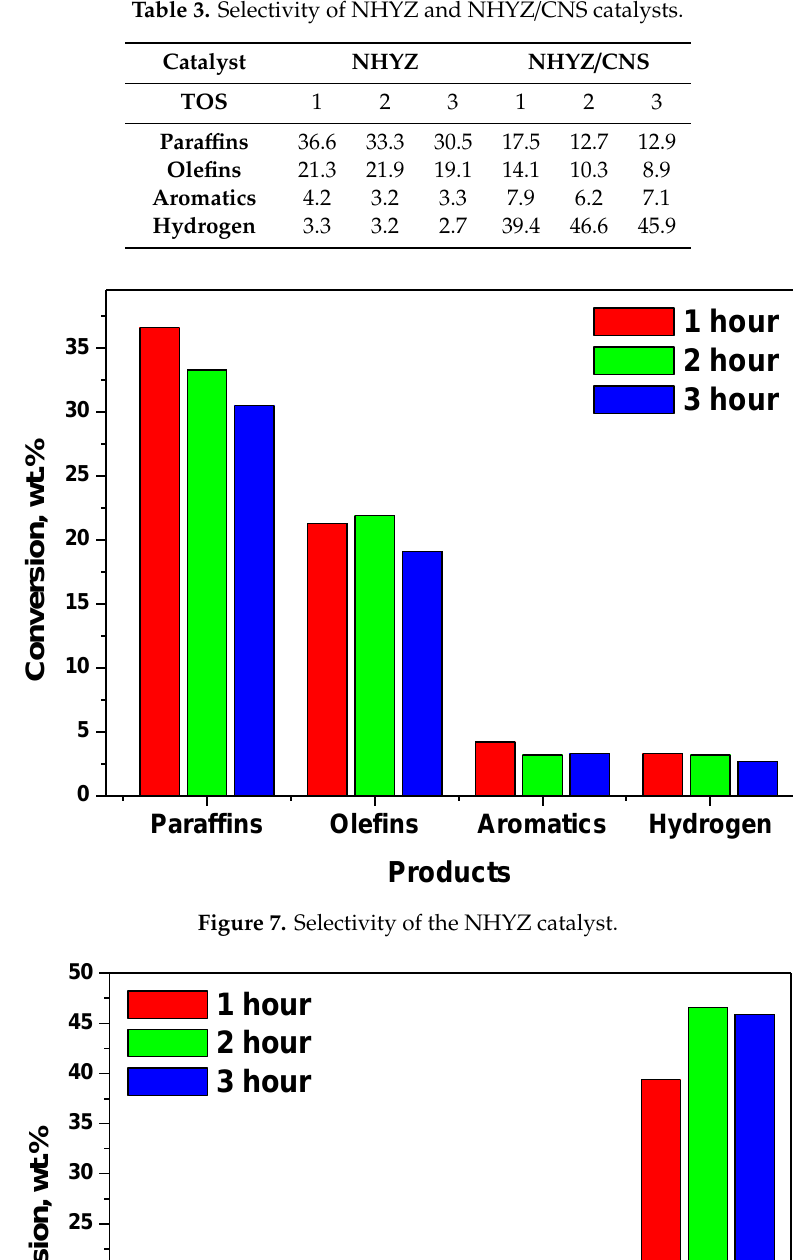
Figure 8. Selectivity of the NHYZ/CNS catalyst.